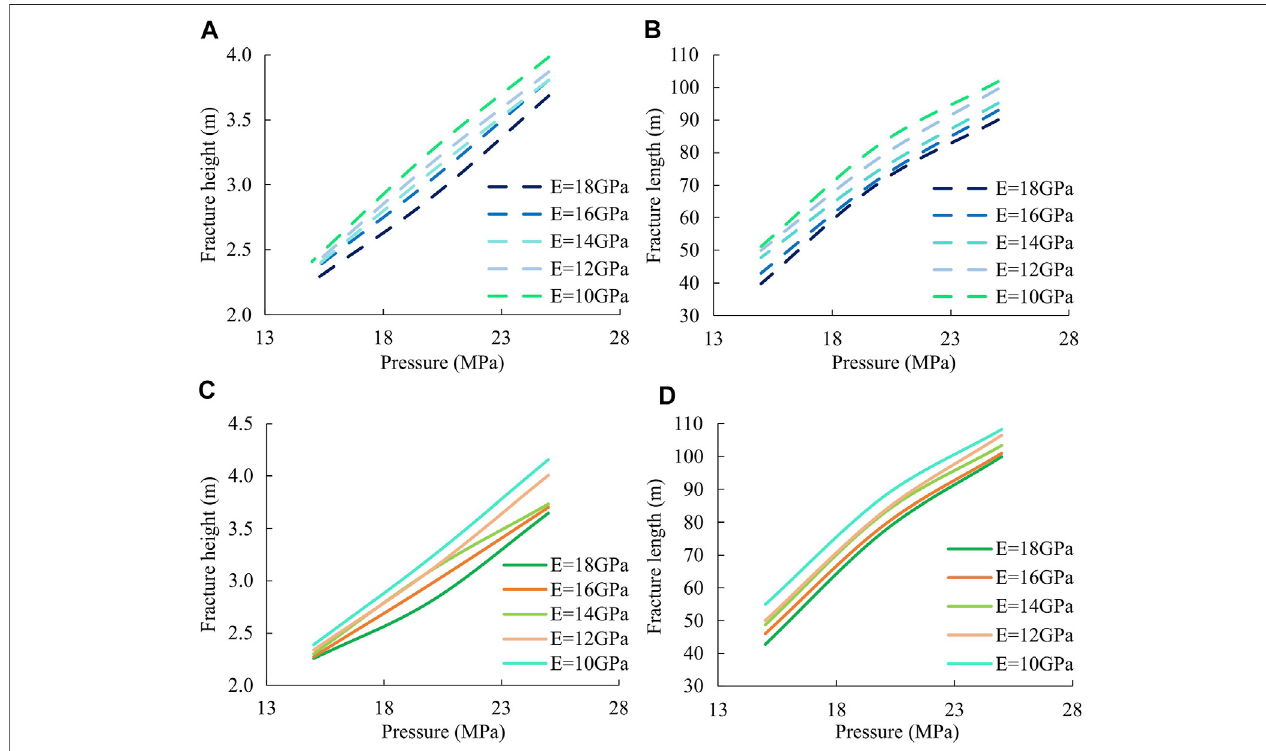
FIGURE9| FractureparametersunderdifferentYoung ’ smodulusoftheroofand fl oor. (A) ThefractureheightoftheNo.9coalseam. (B) Thefracturelengthofthe No. 9 coal seam. (C) The fracture height of the No. 13 coal seam. (D) The fracture length of the No. 13 coal seam.